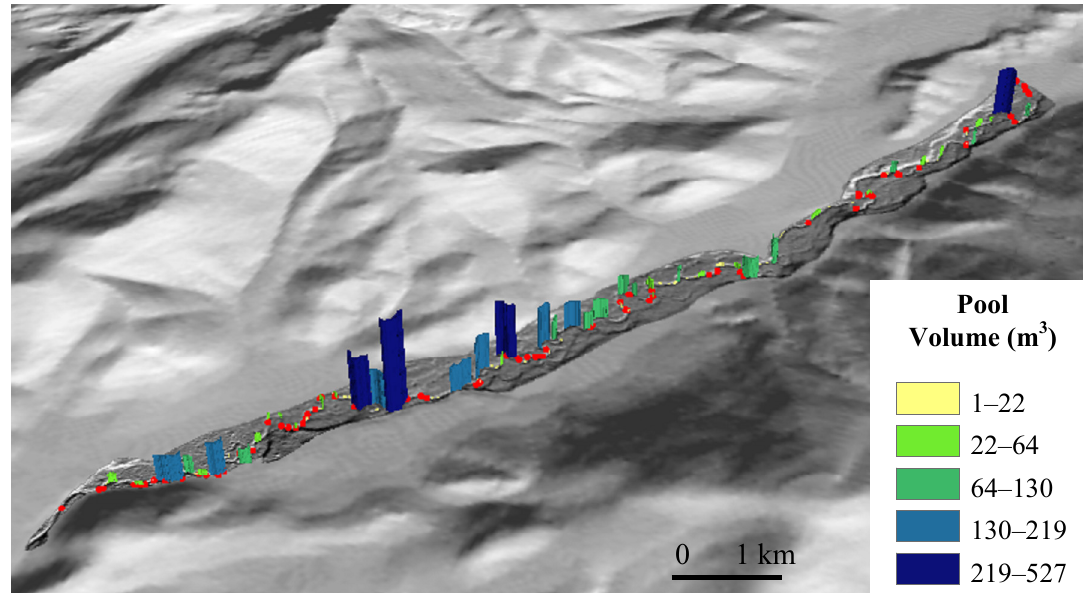
Figure 12. Histogram of pool distribution in upper Bear Valley Creek, Middle Fork Salmon River drainage, ID, USA. The volume of pools was calculated in each consecutive 300 m reach of this 10 km-long stream segment. EAARL data which cover the channel and floodplain are inset in a standard 10 m DEM. Red dots are locations of individual Chinook salmon spawning nests in